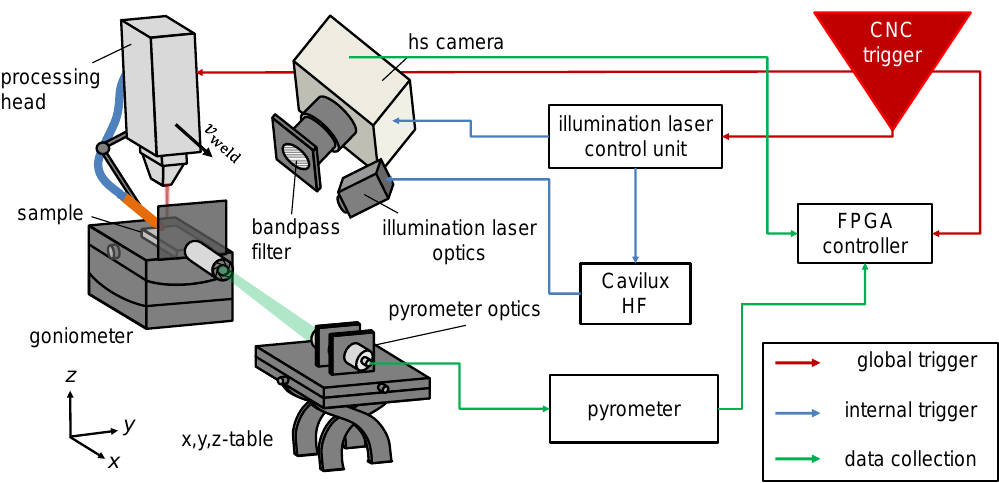
Figure 4. Experimental setup for measuring the temperature near the keyhole front wall. FPGA: field programmable gate array; CNC: computerized numerical control.